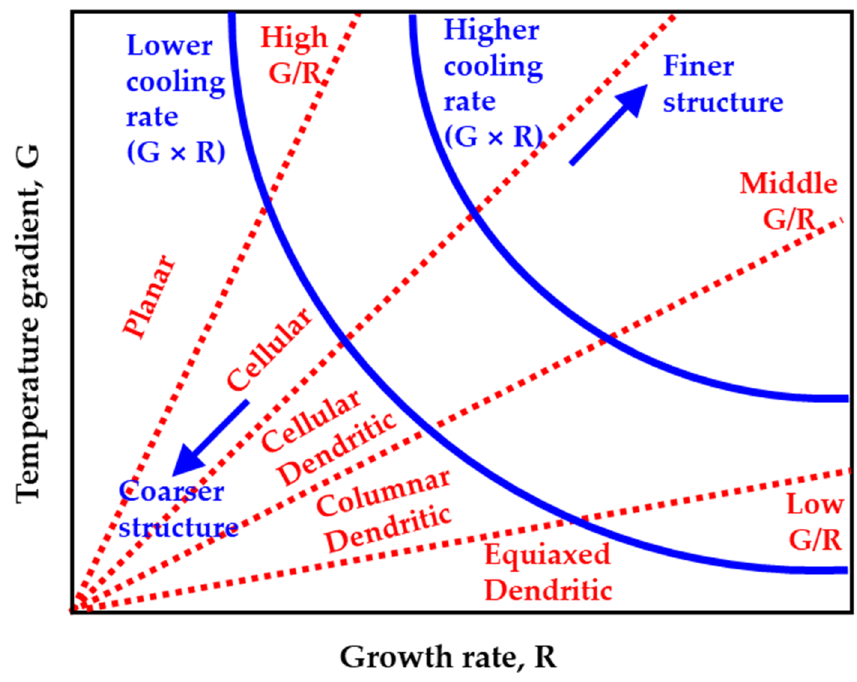
Figure 4. Solidification map; effect of temperature gradient and growth rate on the morphology and size of solidification microstructure [3].